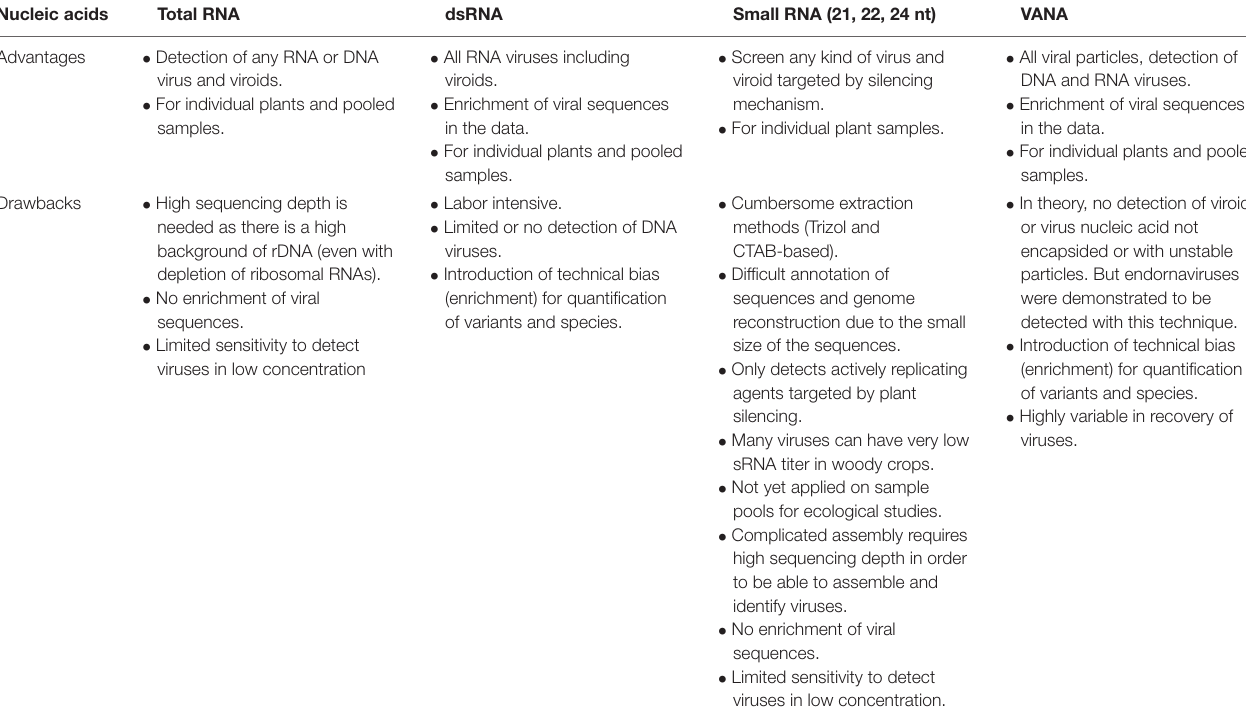
TABLE 1 | Advantages and drawbacks of different sample preparations for HTS-based virus ecological studies. Nucleic